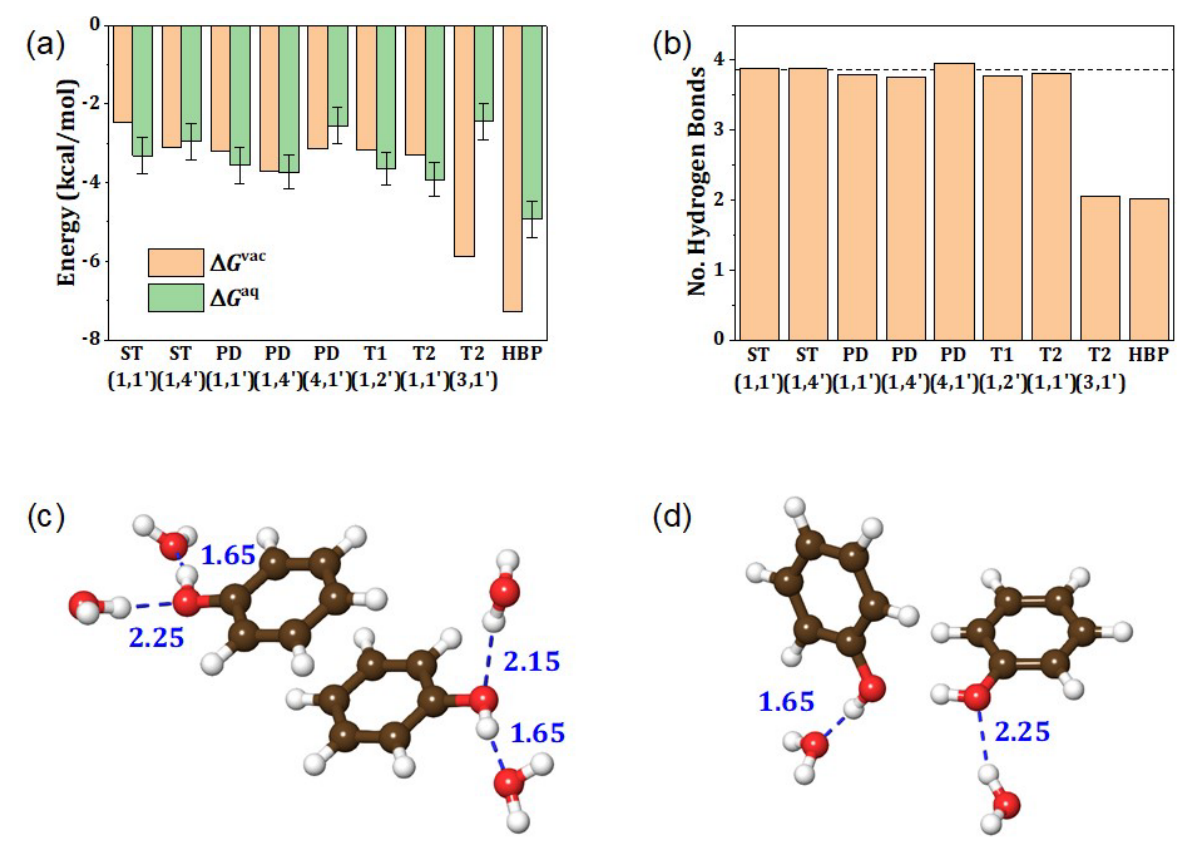
Figure 4. ( a ) Association free energy of phenol dimers in vacuum ( ∆ G vac ) and in water ( ∆ G aq ). ( b ) Average number of water–hydroxyl hydrogen bonds present in phenol dimers. The dashed line represents twice the average number of hydrogen bonds of phenol monomer. ( c , d ) Schematic illustrating the water–hydroxyl hydrogen bonds of ( c ) PD (4, 1′ ) and ( d ) HBP conformation. The numbers are H-bond distances in angstroms, which are taken from the first peak locations of radial distribution functions shown in Figure S4.